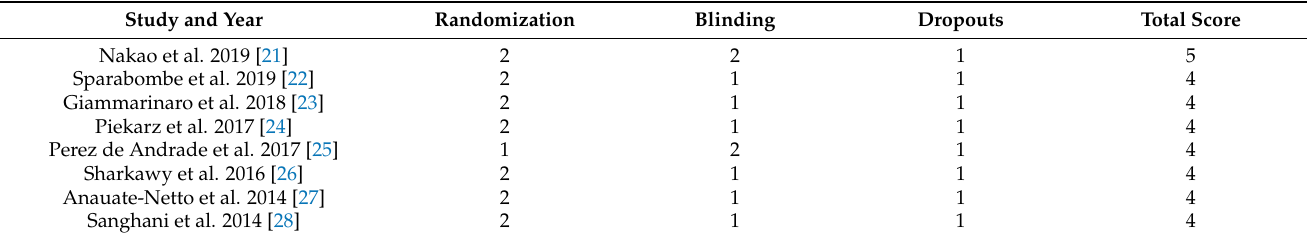
Table 1. Jadad quality score of randomized controlled trials included in the meta-analysis. Study and Year Randomization